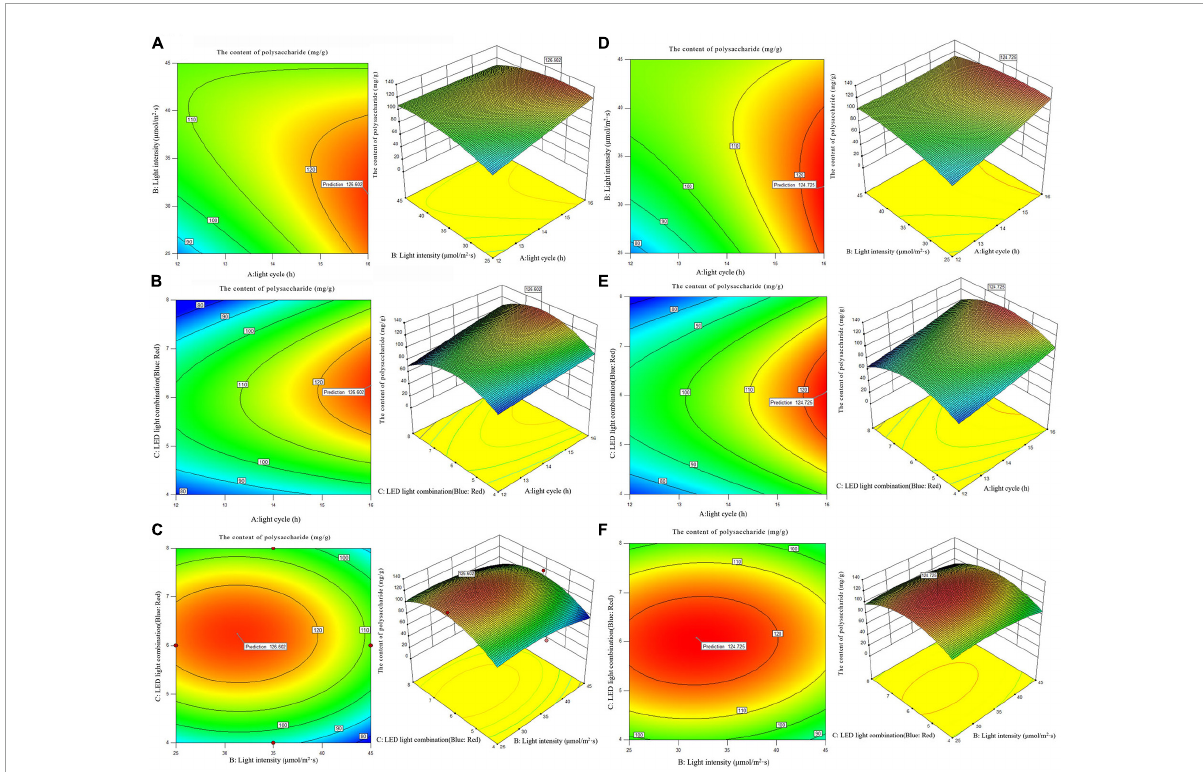
FIGURE5 2D contour diagram and 3D surface diagram of polysaccharide content of Arthrospira platensis OUC623 and A. platensis OUC793. (A) Contour diagram and response surface diagram of polysaccharide content of 623 with light time (12, 14, and 16 h) and light intensity (25,35,45 µ mol/m 2 s) under the light of blue6:red1. (B) Contour diagram and response surface diagram of polysaccharide content of 623 with light time (12, 14, and 16 h) and red and blue light combination (blue: red = 4:1, 6:1, 8:1) under light intensity of 35 µ mol/m 2 s. (C) Contour diagram and response surface diagram of polysaccharide content of 623 with red and blue light combination (blue: red = 4:1, 6:1, 8:1) and light intensity (25, 35, and 45 µ mol/m 2 s) under the light cycle of L14:D10. (D) Contour diagram and response surface diagram of polysaccharide content of 793 with light time (12, 14, and 16 h) and light intensity (25, 35, and 45 µ mol/m 2 s) under the light of blue6:red1. (E) Contour diagram and response surface diagram of polysaccharide content of 793 with light time (12, 14, and 16 h) and red and blue light combination (blue: red = 4:1, 6:1, 8:1) under light intensity of 35 µ mol/m 2 s. (F) Contour diagram and response surface diagram of polysaccharide content of 793 with red and blue light combination (blue: red = 4:1, 6:1, 8:1) and light intensity (25, 35, and 45 µ mol/m 2 s) under the light cycle of